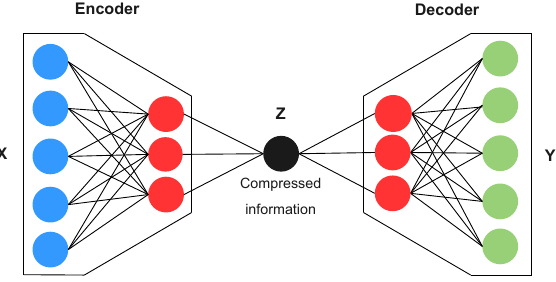
Figure 4. Sketch of the AE base